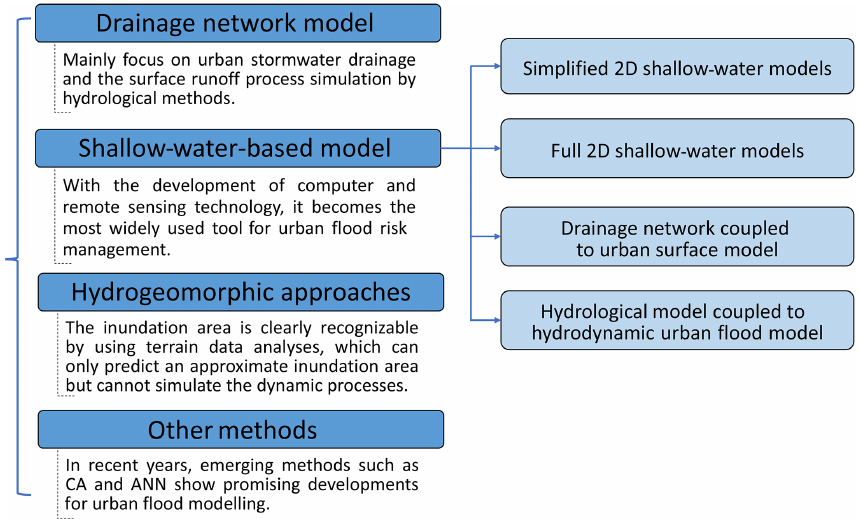
Figure 1. Four main groups of models in the ongoing